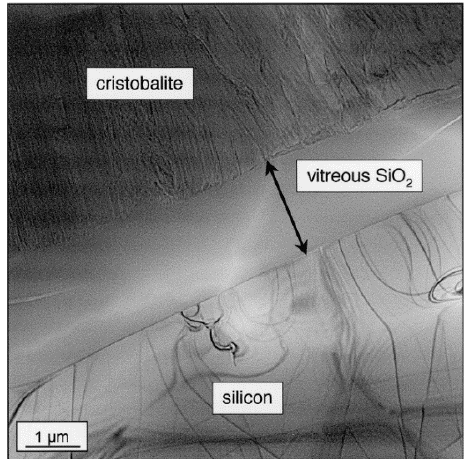
Figure 17. Cross-sectional TEM image of the thin underlying dense layer on pure silicon exposed for 500 h in air + 15 vol% H 2 O at 1200 °C and 10 bar. Reprinted with permission from Reference [67]. Copyright 2003 The American Ceramic Society/Wiley.